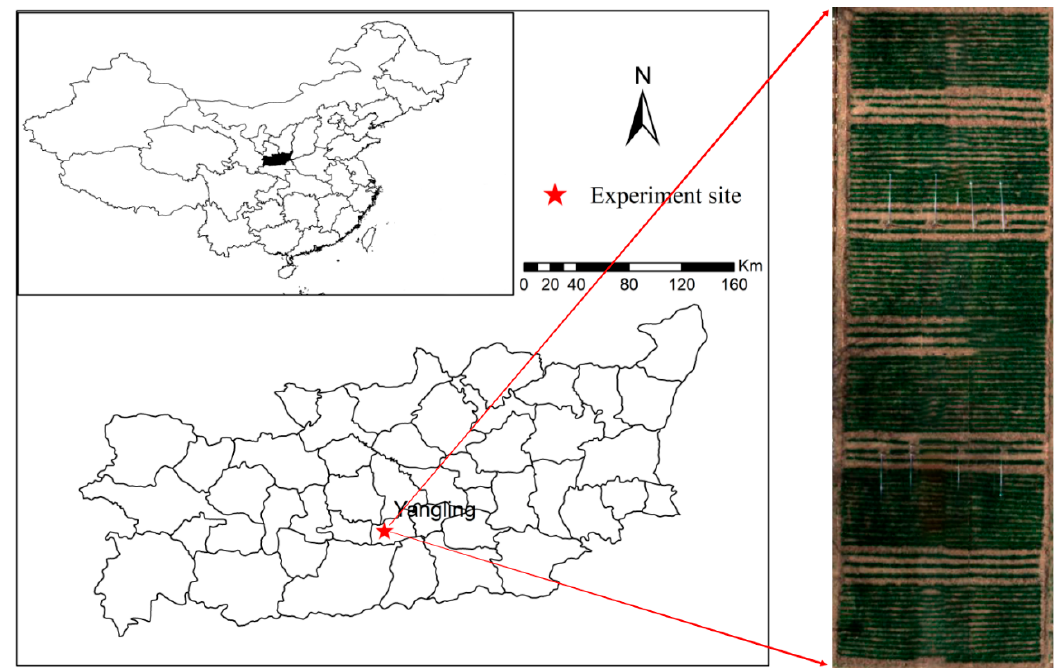
Figure 1. Aerial photograph of winter wheat research area and some sampling plots in Yangling, Shaanxi.